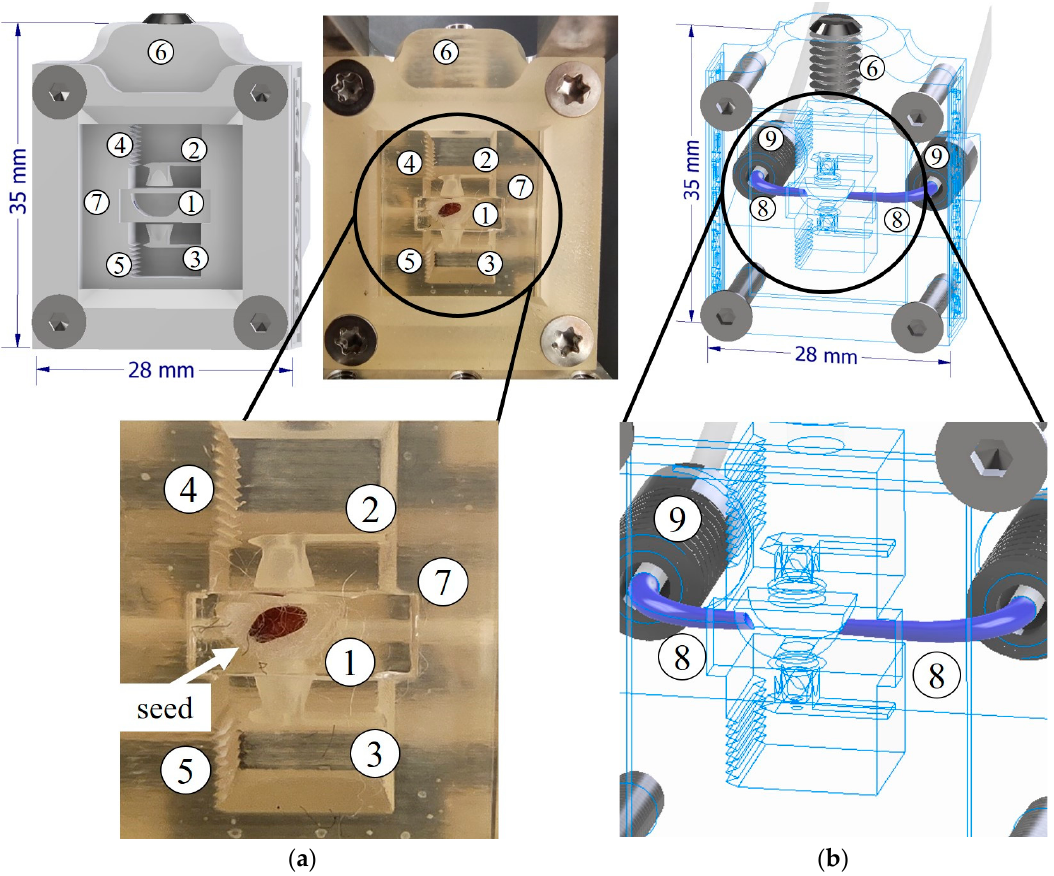
Figure 2. The 3D-printed micropot for a nanosatellite payload: ( a ) CAD design and assembled micropot prepared for the experiment with a seed placed in the socket; and ( b ) Transparent model of the micropot that shows the position of the microfluidic channels. (1) Seed socket; (2) stalk force sensor; (3) root force sensor; (4) force sensor deflection scale; (5) root sensor deflection scale; (6) semi- permeable air supply; (7) protecting glass window; (8) integrated 3D-printed microfluidic channel; and (9) microfluidic connector.